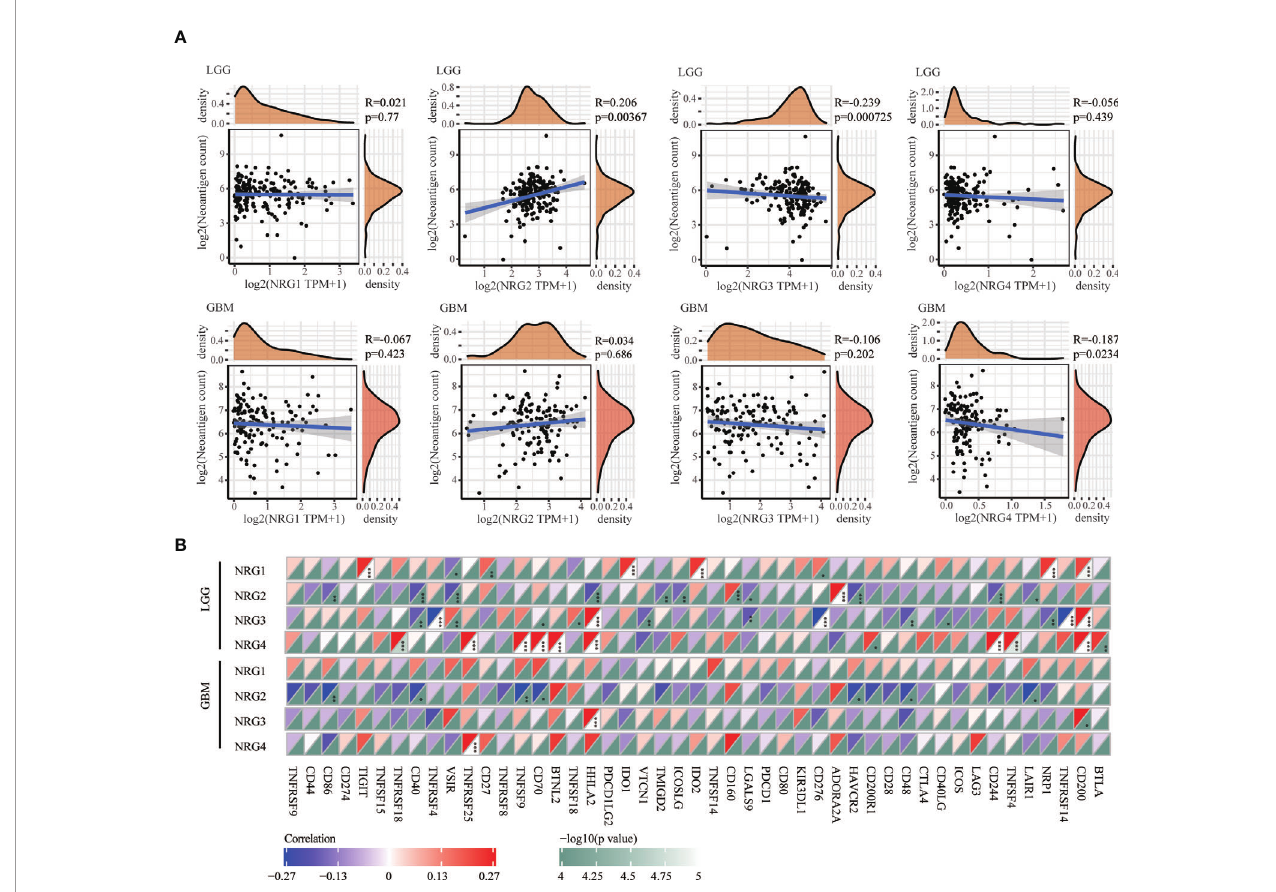
FIGURE 7 | Correlations between NRGs expression and neoantigens/immune checkpoint in LGG and GBM. Correlation analysis of NRG1-4 expression and neoantigen counts in LGG and GBM (A) . The horizontal axis represents the expression distribution of NRG1-4, and the ordinate is the distribution of neoantigen counts. The density curve on the right represents the distribution trend of neoantigen counts; the upper density curve represents the distribution trend of NRG1-4. Correlations between immune checkpoint-related genes and the expression of NRG1-4 in LGG and GBM (B) . Spearman ’ s correlation analysis was used to describe the correlation. *P < 0.05; **P <0.01; ***P <